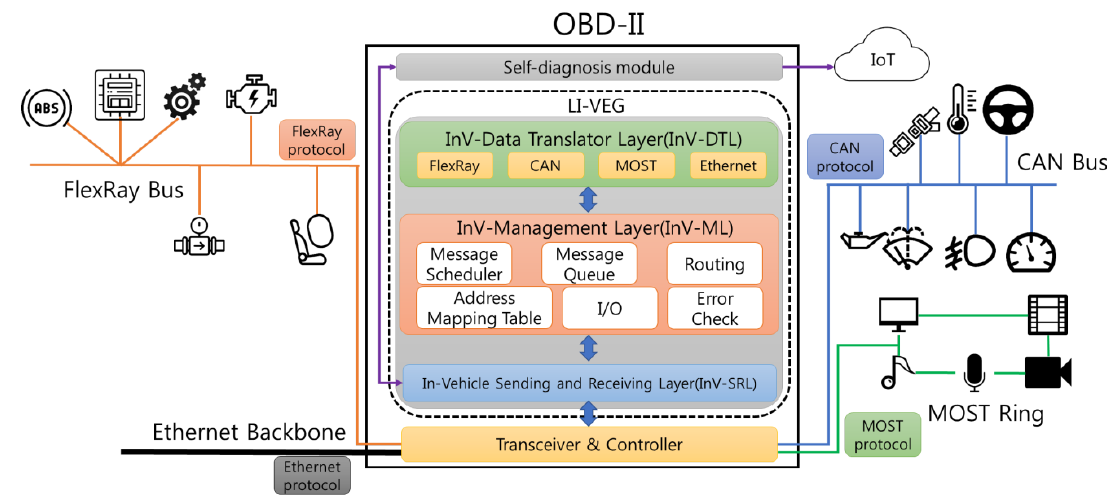
Figure 2. The structure of the LI-VEG.